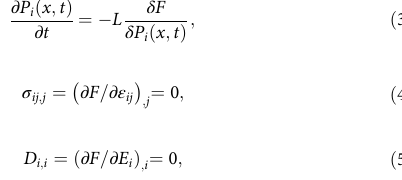
where all repeating subscripts imply summation over the Cartesian coordinate components x i ( i = 1, 2, and 3) and ‘ , i ’ denotes the partial derivative operator with respect to x i (i.e., ∂ / ∂ x i ); P i is a component of the polarization vector P , ε ij mechanical strain and E i electric fi eld; α ’ s are the Landau expansion coef fi cients (up